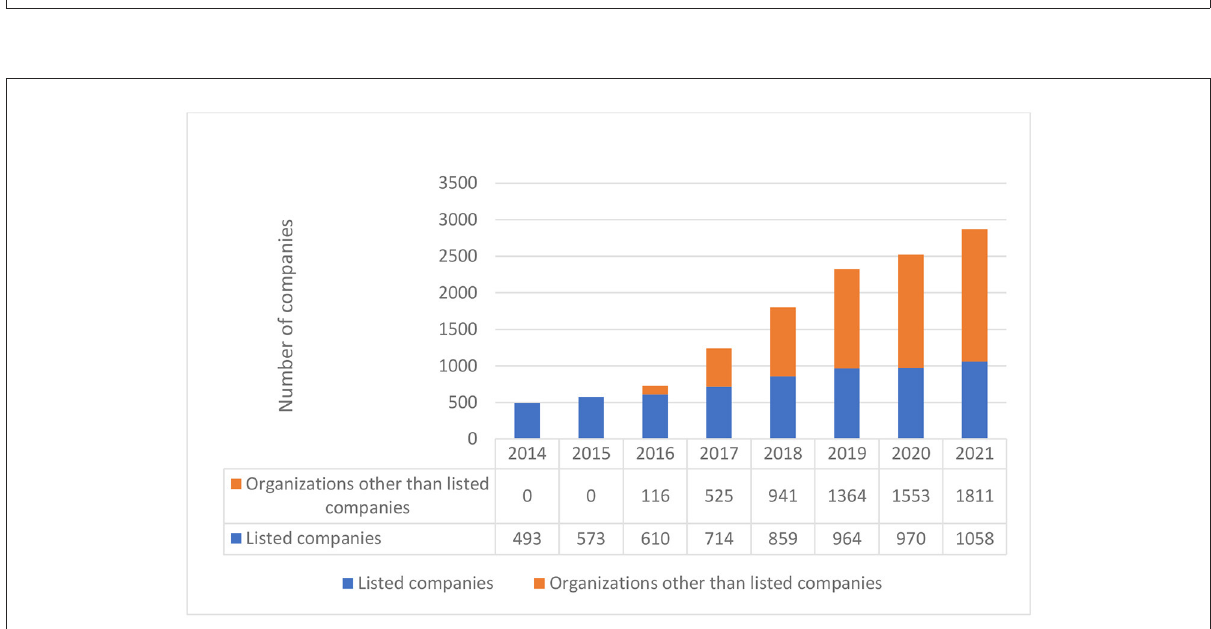
FIGURE2 Number of companies that participated in the HPM